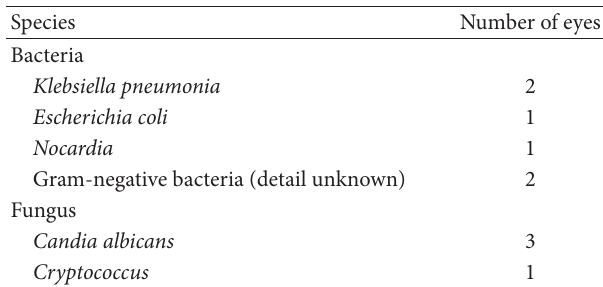
Table 1: Cultures results.